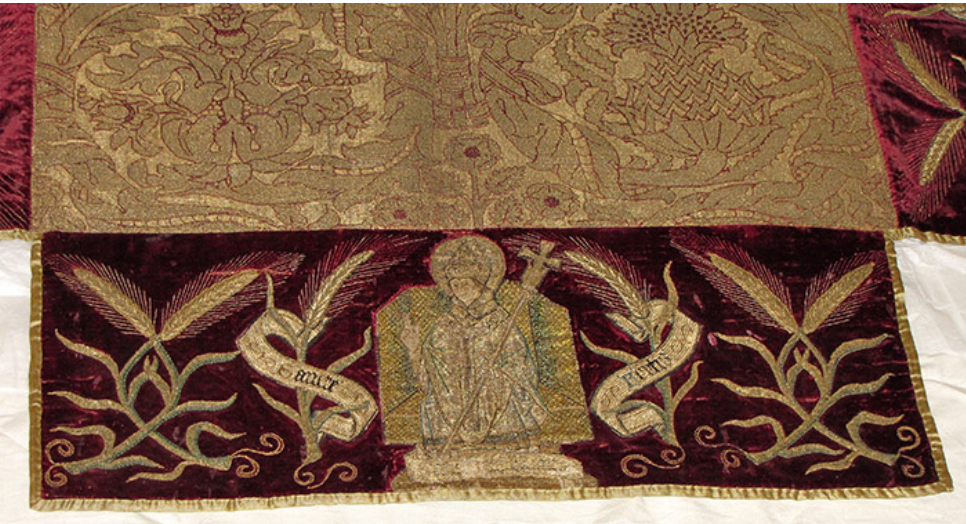
Figure 24. Pall Cloth, detail: Thomas Becket, end of the 15th to early 16th century, London, Brewers’ Hall, Worshipful Company of Brewers, England. © Index of Medieval Art, Princeton.